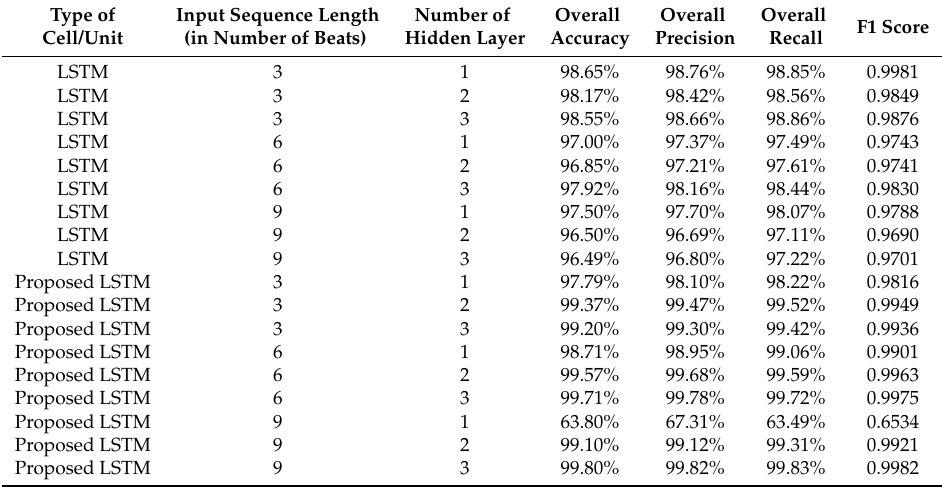
Table 8. Performance summary of the proposed bidirectional LSTM in MITDB analysis 3 of Figure